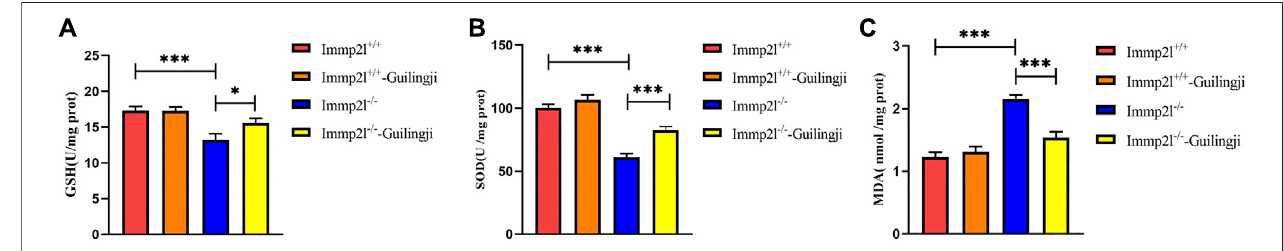
FIGURE 3 | The effects of Guilingji on activities of SOD, GSH and MDA. (A – C) Activities of SOD, GSH and MDA were detected by kits respectively. The bars showed means ± SEM. * p < 0.05 and *** p < 0.001. n (cid:1) 6.